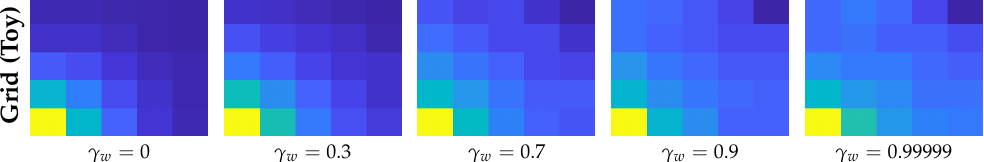
Figure 21. Visitation count for W β at the end of the learning on the same random seed (out of 20). N The higher the discount, the more uniform the count is. The initial state (bottom left) has naturally higher counts because the agent always starts there. W β performed very UCB